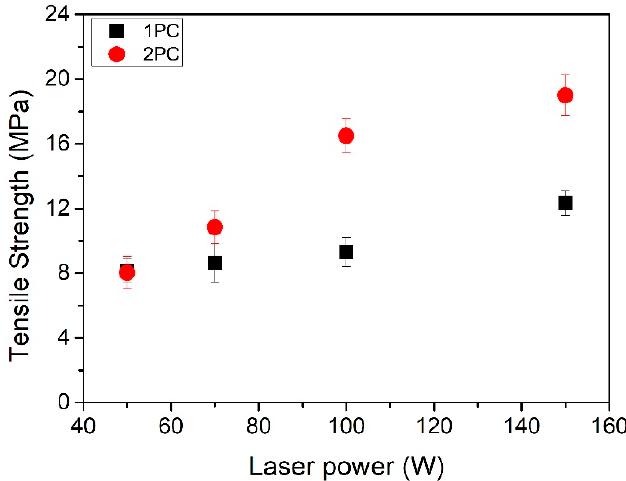
Figure 10. Tensile strength of joints using laser joining with different laser powers.